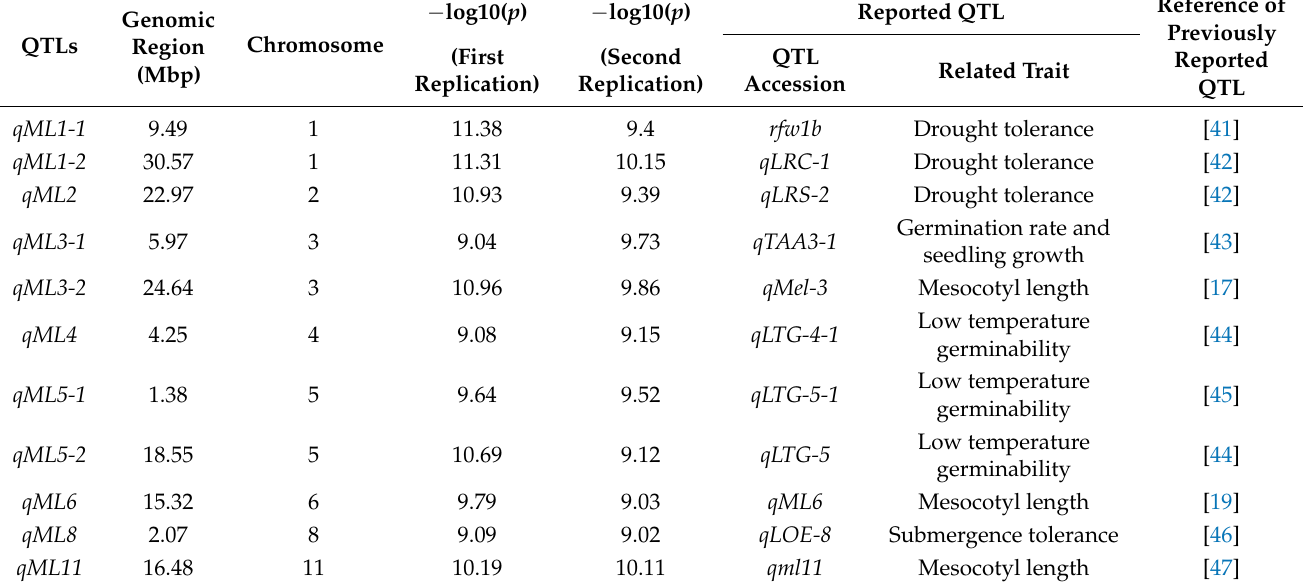
Table 1. Genome-wide association loci with mesocotyl length and previously reported quantitative trait loci